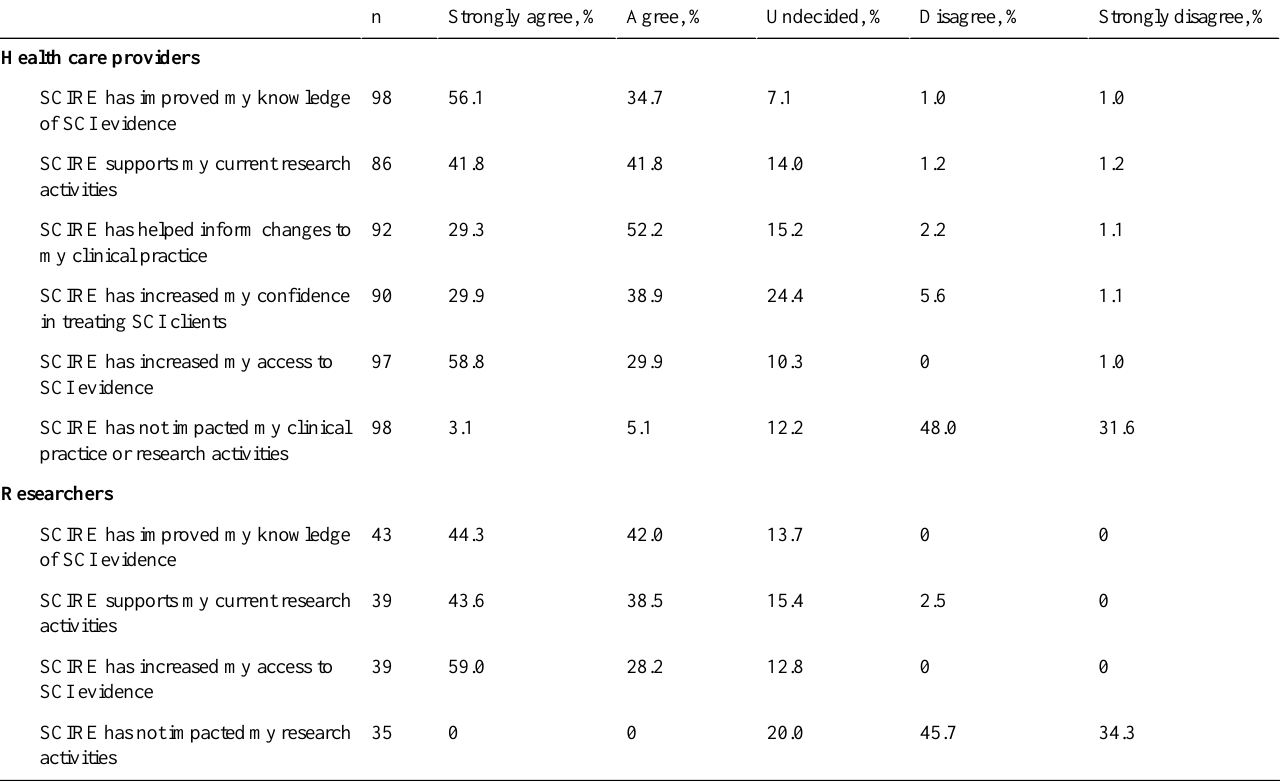
Table 1. Website survey results showing impact of SCIRE on health care providers and researchers (101 health care providers and 45 researchers completed the survey, but some marked an item as not applicable and were not included in the percent calculation, eg, a clinician who had no research responsibilities for item